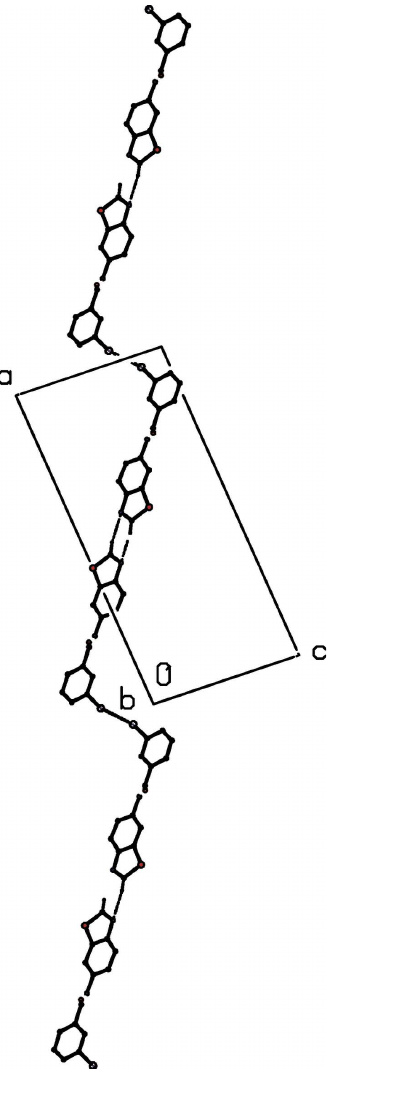
Figure 6 A projection along [010] of part of the crystal structure of (I) showing how the Br (cid:3)(cid:3)(cid:3) Br interactions (dashed lines) link the hydrogen-bonded ribbons into sheets lying parallel to